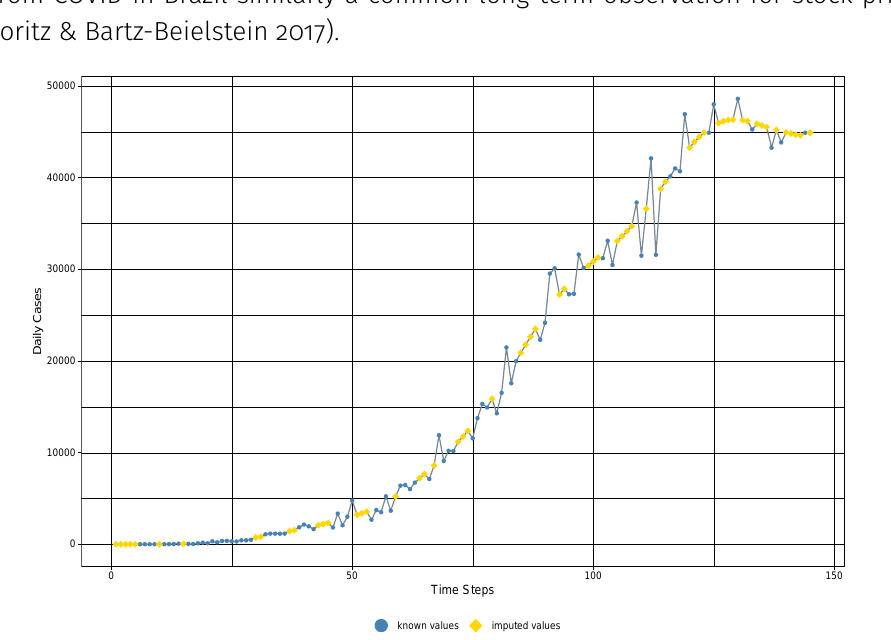
Figure 21. Result after statistical imputation for anomaly values identified at COVID daily cases from